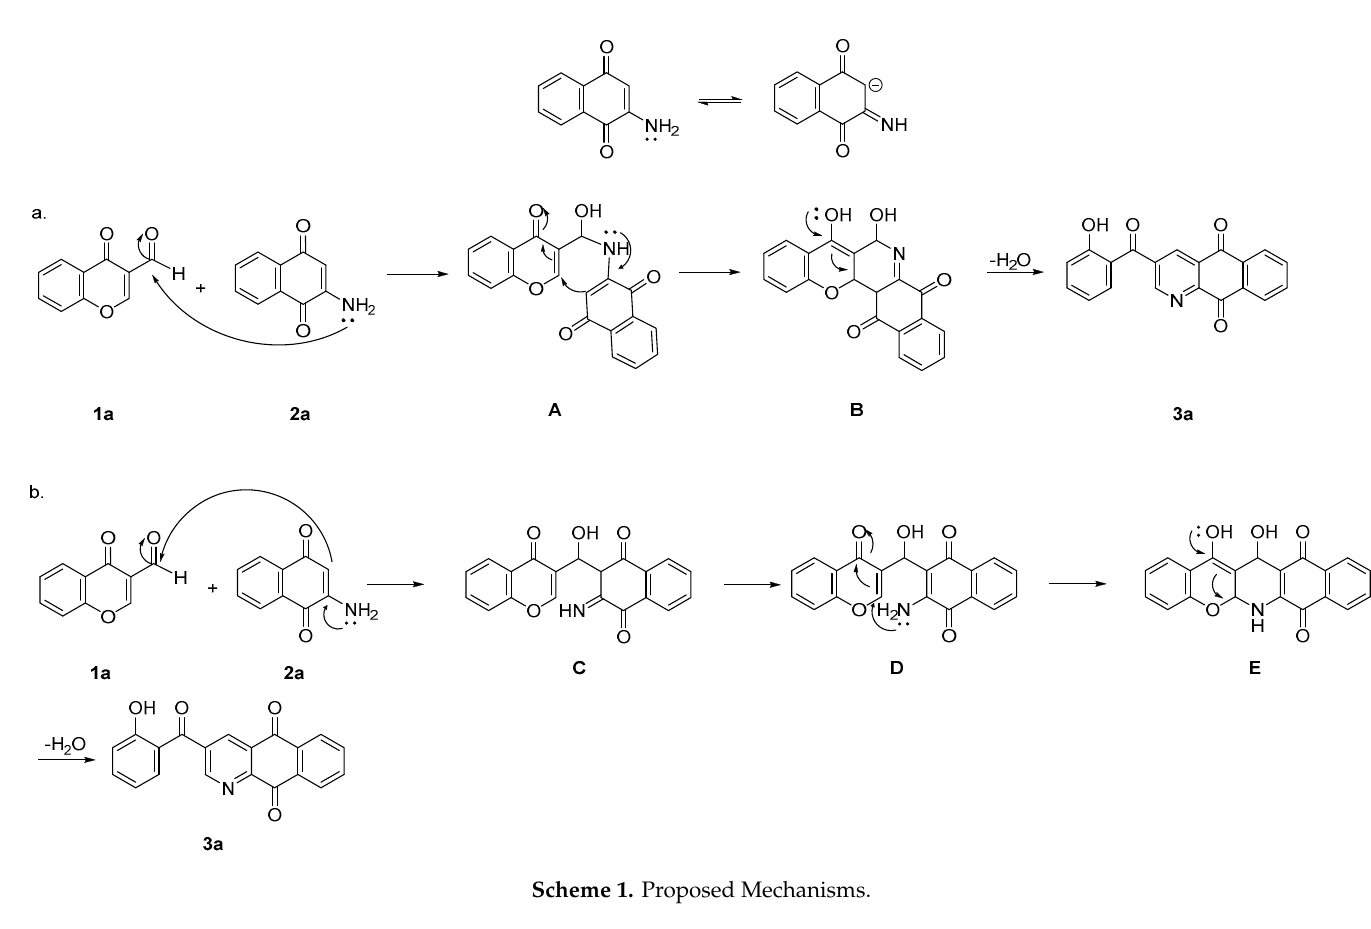
Figure 3. The single crystal structure of 3t .